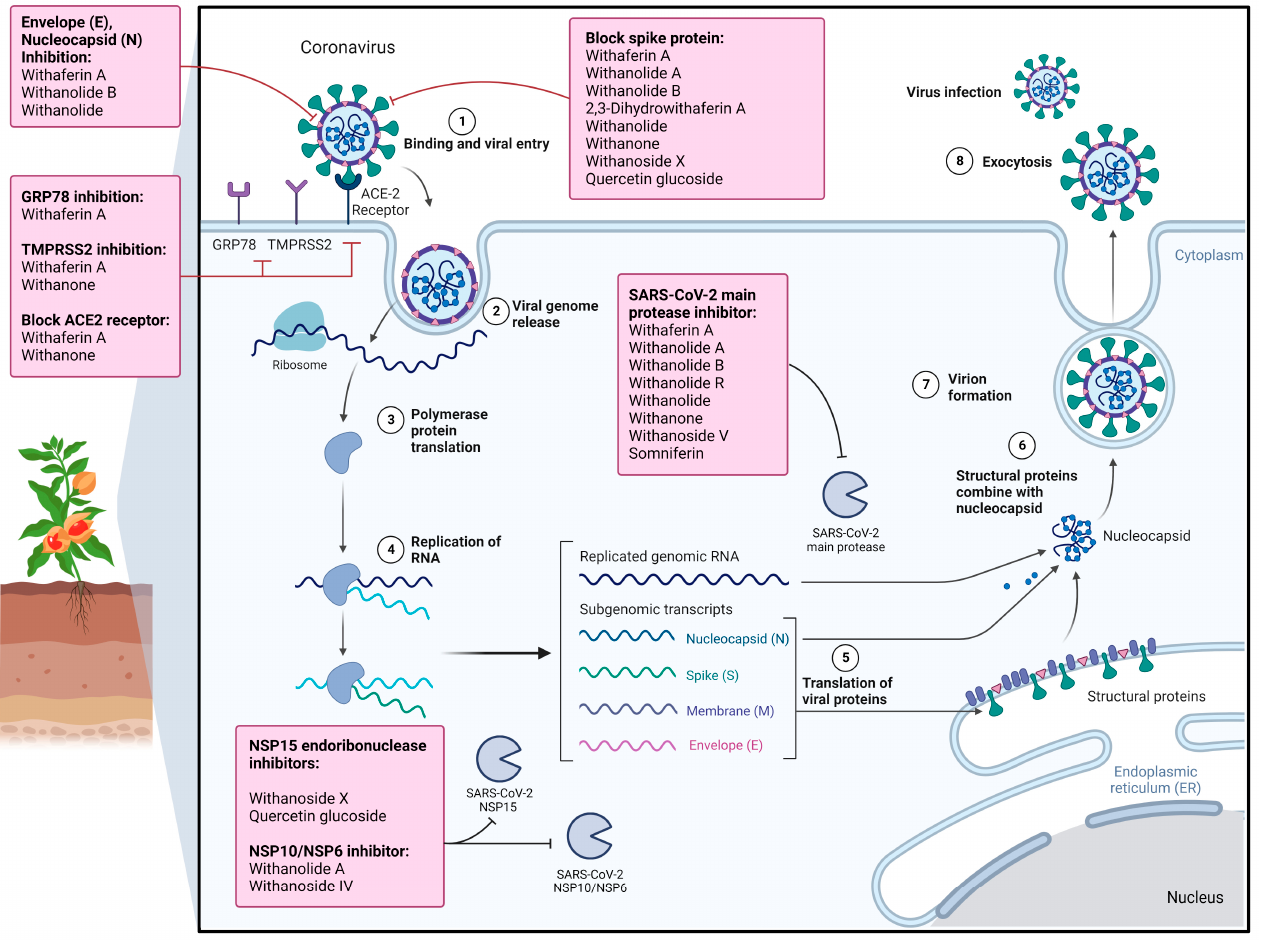
Figure 6. Overview of molecular mechanisms of WS phytochemicals against SARS-CoV-2. WS phytochemicals inhibit viral entry by inhibiting SARS-CoV-2 S, E, and N proteins, as well as host ACE2, TMPRSS2, and GRP78. Meanwhile, WS phytochemicals also prevent viral replication by inhibiting the viral main protease, NSP15 endonuclease, and NSP10/NSP6 protein complex.